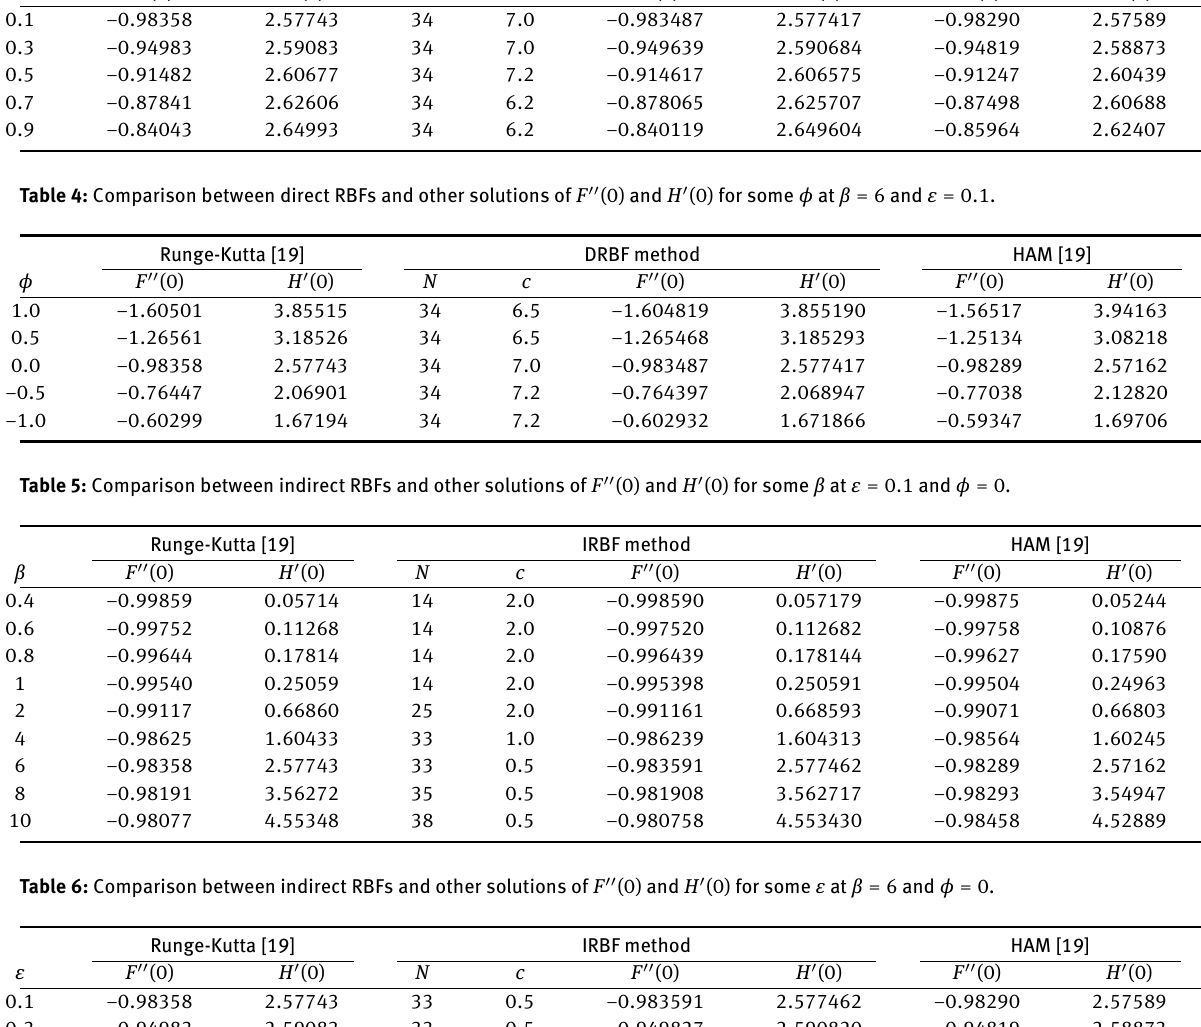
Table 3: Comparison between direct RBFs and other solutions of F (cid:48)(cid:48) (0) and H (cid:48) (0) for some ε at β = 6 and ϕ = 0 . Runge-Kutta [19] DRBF method